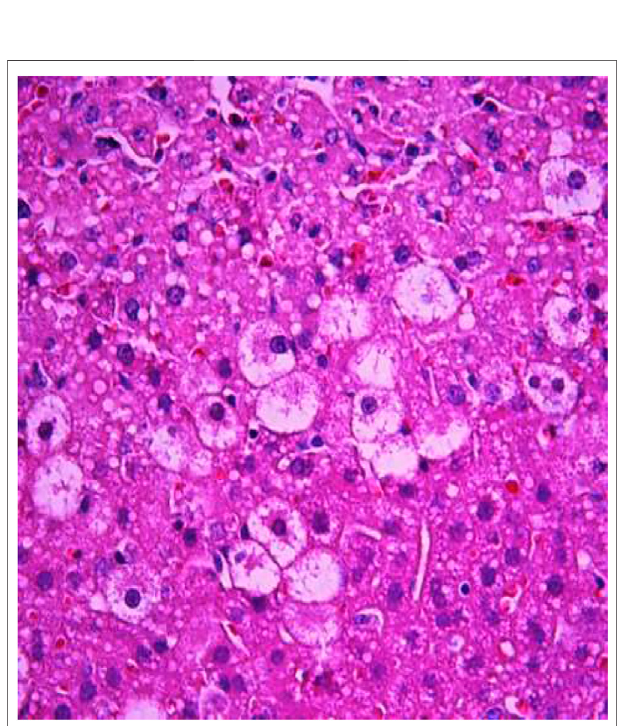
FIGURE 7 | Liver tissue. Positive control group. Hyperemia of the capillaries in the sinusoids. Hydropic and vacuolar degeneration of hepatocytes. Stain: hematoxylin and eosin. Magni fi cation × 400.